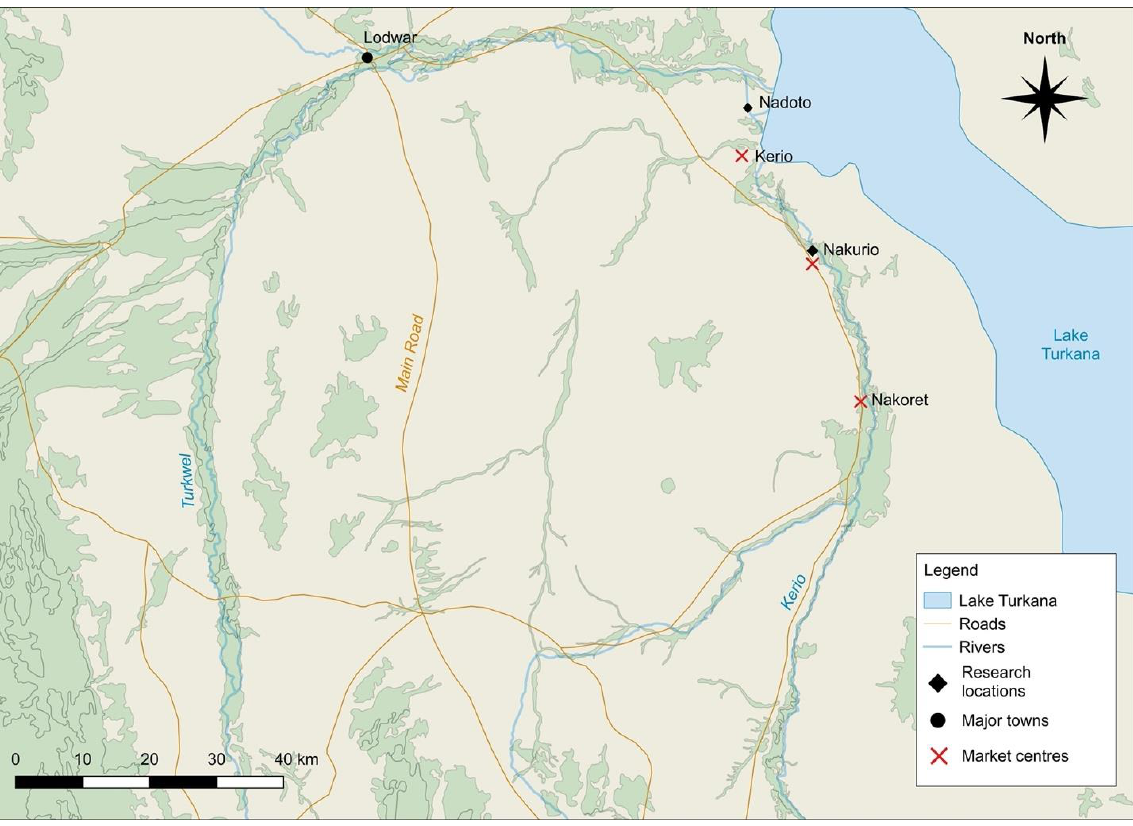
Figure 2. Map showing the lower courses of the Kerio and the Turkwel. Note, both rivers have numerous trading centres along them, this map shows only those centres on the Kerio that were regularly visited during the course of our research.